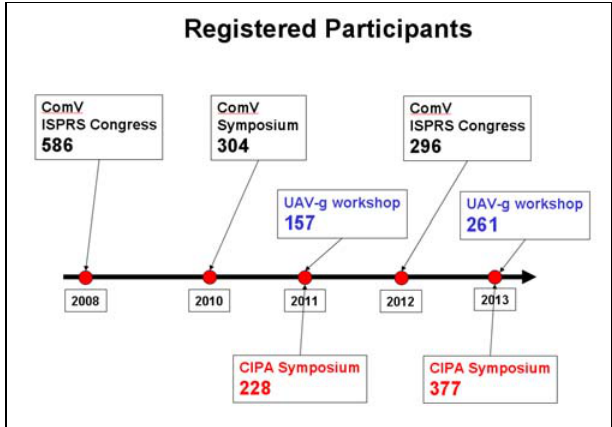
Figure 2. The critical mass of our “close-range imaging” society All in all, looking back at the last years (Fig. 2), a decrease in participation to Com V symposia is observed, while a dedicated group of about 300 researchers exist. At the same time CIPA represents a more or less constant group of 300 researchers, with some sort of overlap to Com V group. Finally, worth over the last